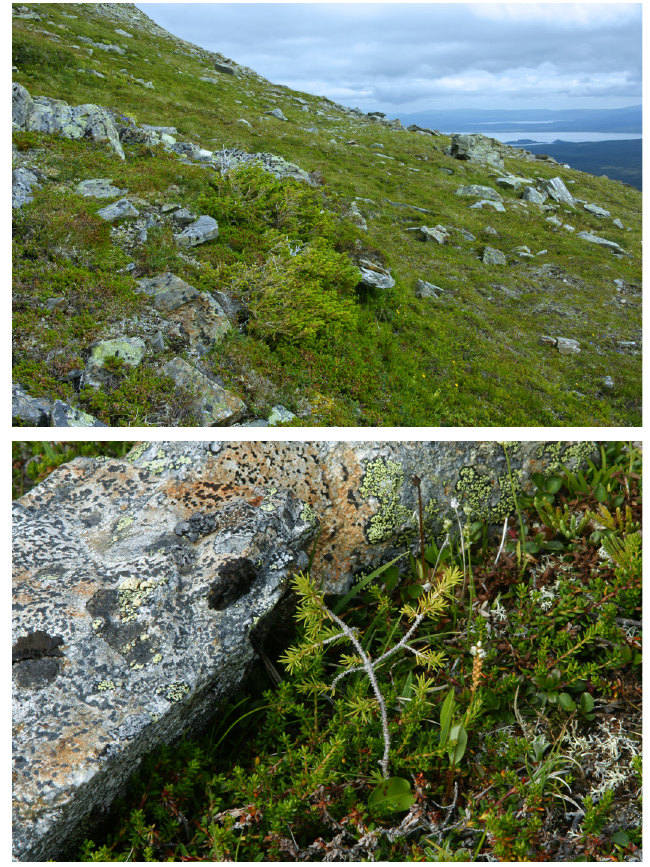
Figure 21: Upper. Many krummholz spruces growing in the alpine tundra are old-established relicts from warmer epochs in the distant past. In this mode, spruce is the hardiest tree species in the Scandes. Radiocarbon-dated megafossils right underneath the canopy indicate that this individual existed already about 1300 years ago (Kullman 2001). This spruce, which is entirely snow-covered in the winter, was described by Kilander (1955). Its physiognomy has not changed per- ceivably since then. Lower. In 2004, a tiny sapling was disco- vered and tagged, about 4 m leeward of the old krummholz spruce. The latter has produced seed filled cones at several occasions during the past decades and is most likely the “mo- ther” of the sapling, which had increased somewhat in size in 2009. Mt. N. Tväråklumpen, 1090 m a.s.l. 1 August